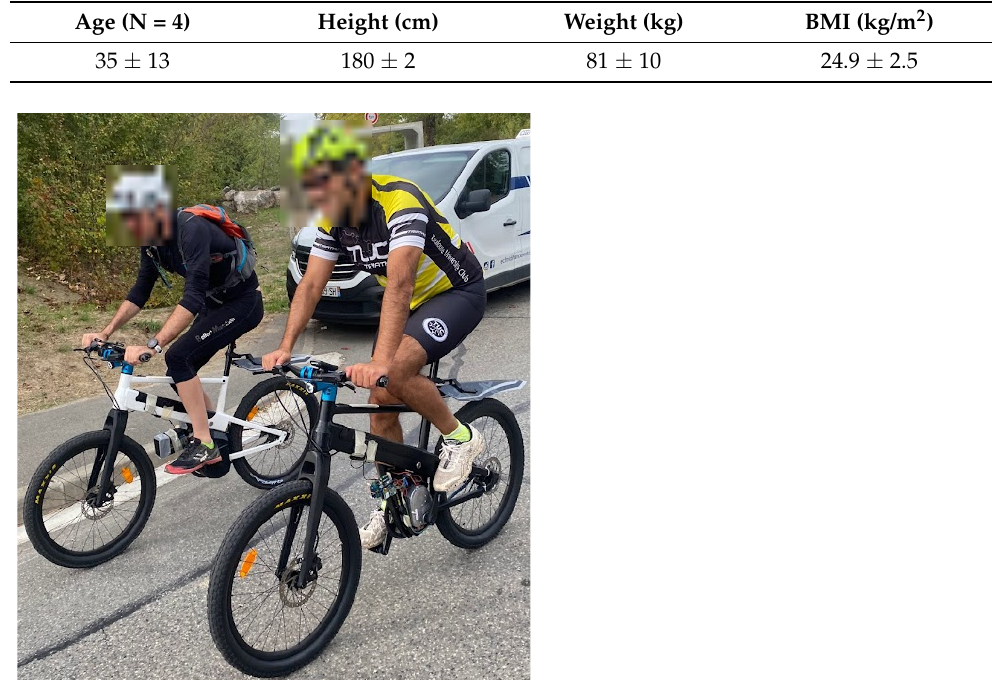
Figure 9. Example photo of participants performing a test.